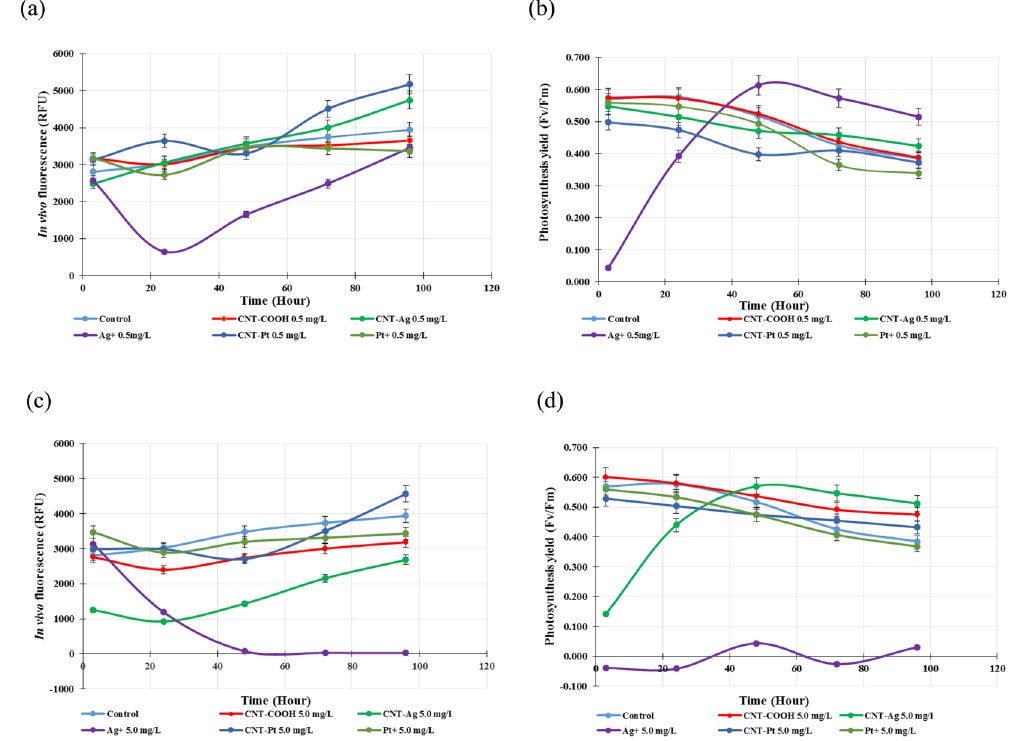
Figure 4. Effects of metal functionalized CNT and metal ions at concentrations of 0.5 ( a ) and 5.0 ( c ) mg/L on in vivo fluorescence. Effects of metal functionalized CNT and metal ions at concentrations of 0.5 ( b ) and 5.0 ( d ) mg/Lon the photosystem II (PSII) quantum yield efficiency (Fv/Fm) of C . reinhardtii